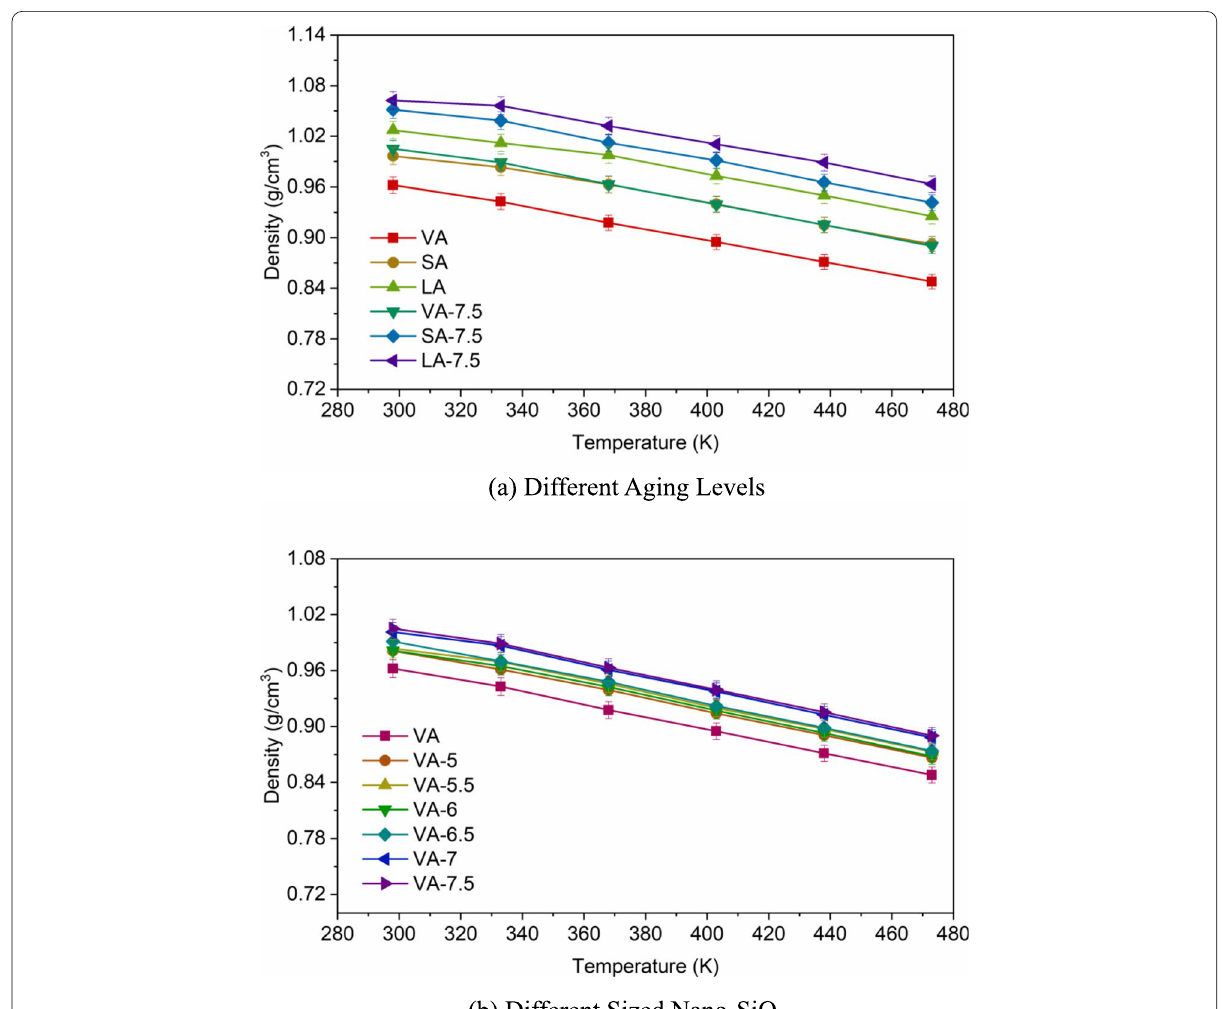
Fig. 8 Density of Asphalt Models at Different Aging Level and with Different Sized Nano-SiO 2 on during 20 ns All-Atom MD Simulations: ( a ) Different Aging Levels, and ( b ) Different Sized Nano-SiO